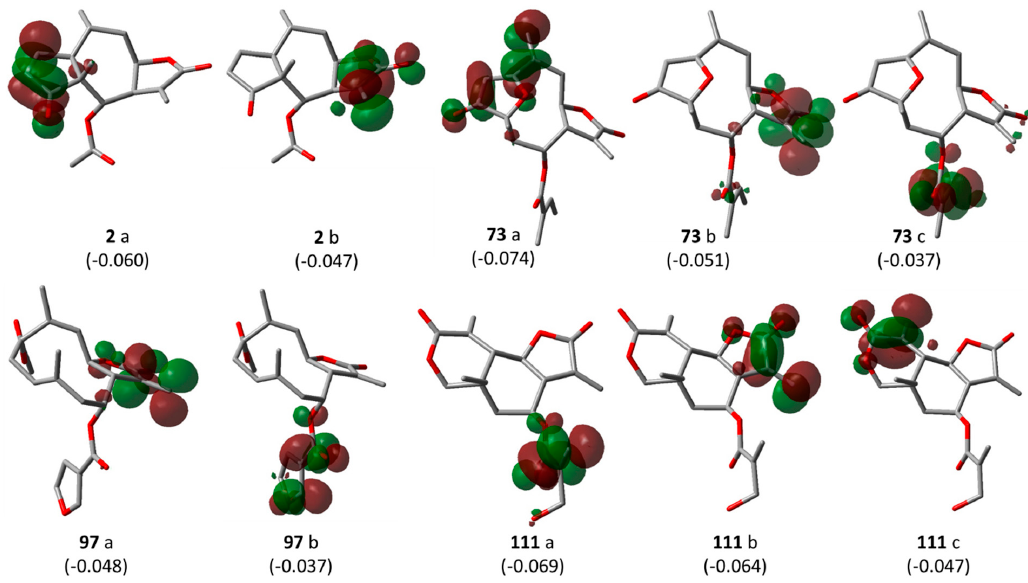
Figure 5. Localization of LUMO frontier molecular orbitals for 2 , 73 , 111 , and 97 (a = LUMO, b = LUMO + 1 and c = LUMO + 2 (isocontour value = 0.045 e); MO eigenvalues reported in brackets).